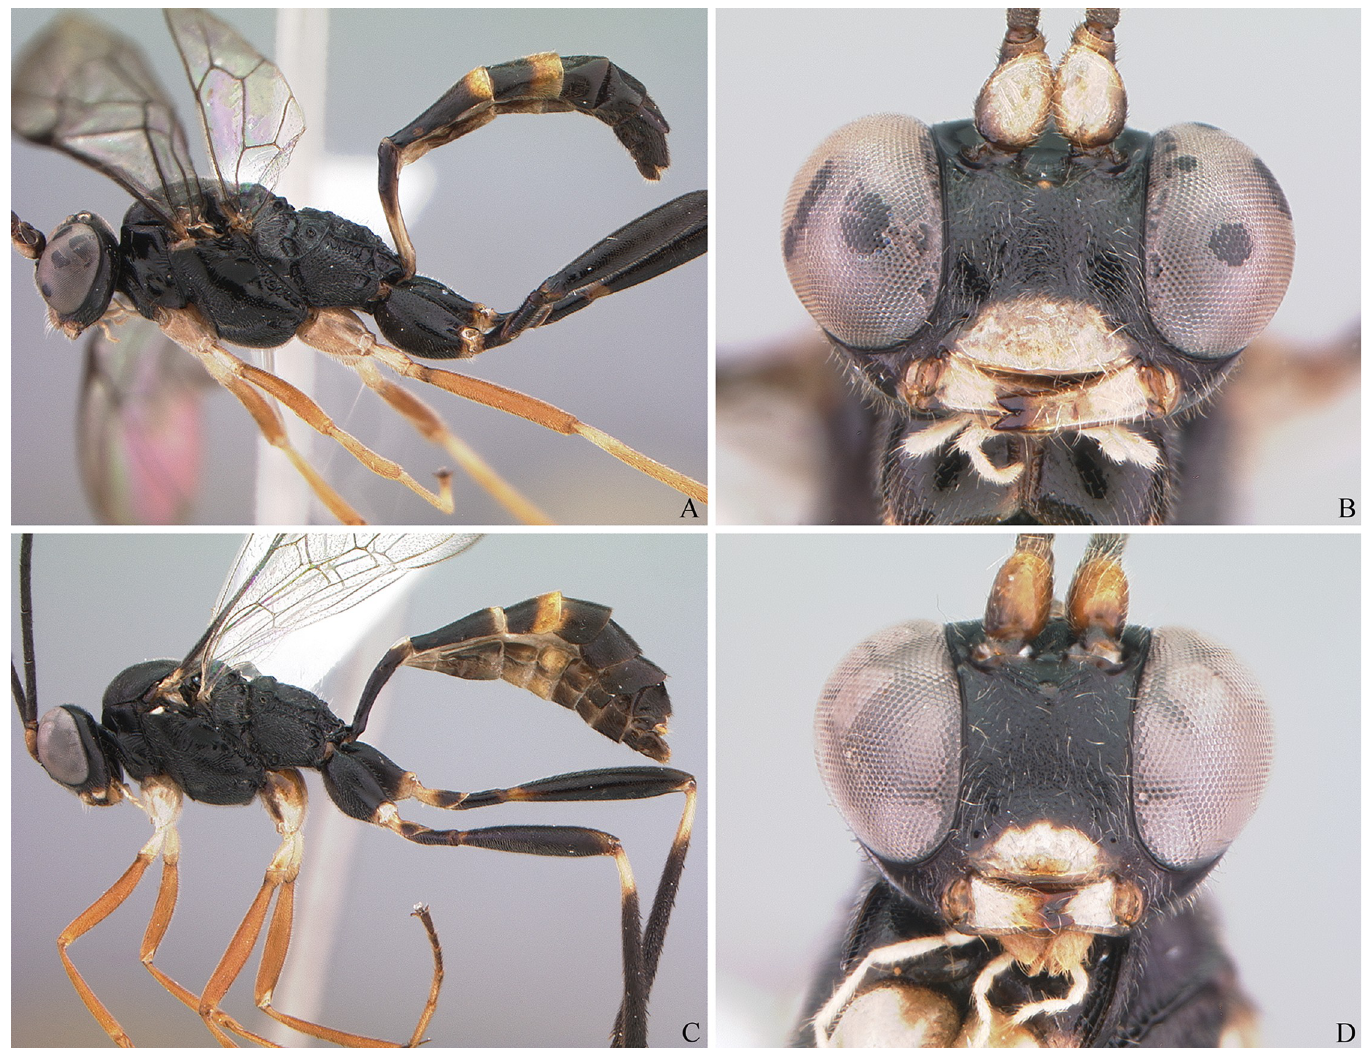
Fig 18. Comparison between a male of Cryptoxenodon metamorphus sp. nov. (top) and a similar Diapetimorpha sp. (bottom). The two specimens were collected from locations 155 Km apart. (A-B) Habitus and head in frontal view; paratype, UFES50549, Alt. 354m, Brazil/BA. (C-D) Habitus and head in frontal view; Diapetimorpha sp., UFES50346, Alt. 51m,